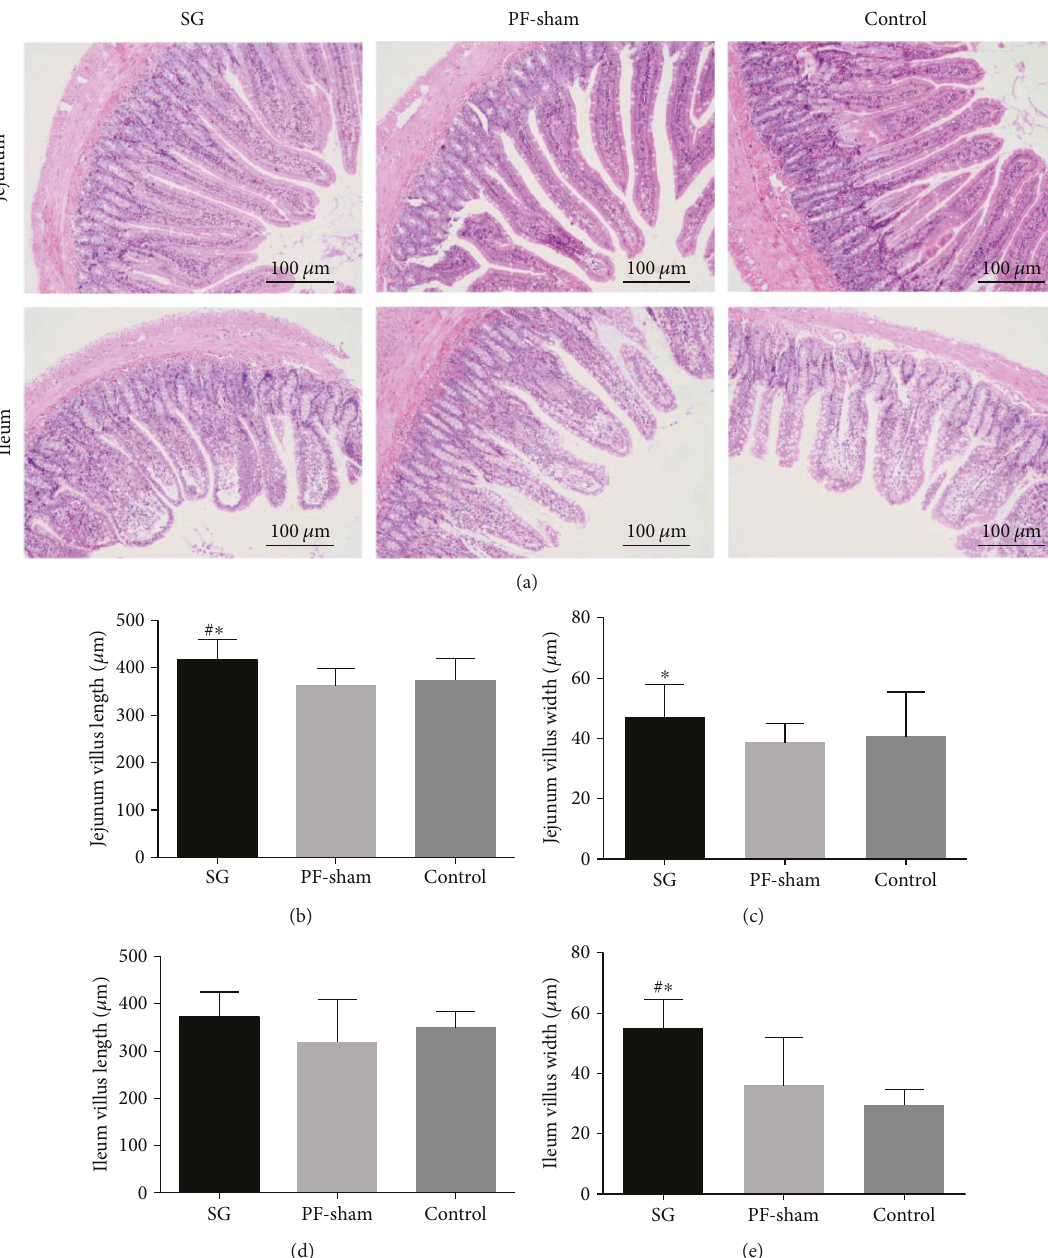
Figure 5: E ff ects of sleeve gastrectomy on the morphology of the jejunal and ileal segments. (a) Representative images of the jejunal and ileal sections of the GK rats stained with hematoxylin-eosin are shown (magni fi cation 100x; scale bar =100 μ m). Bar graphs show the jejunal villus length (b) and width (c) and the ileal villus length (d) and width (e). # P < 0 05 versus the controls; ∗ P < 0 05 versus